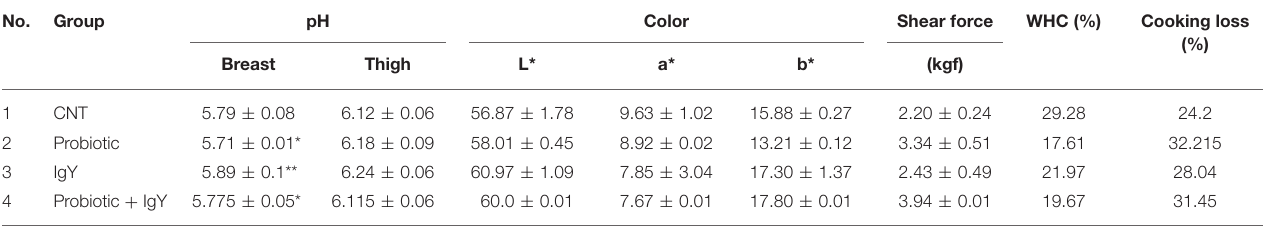
TABLE 4 | pH values of breast and thigh, color, shear force (kgf), water holding capacity percentage, and cooking loss percentage of broilers groups supplemented by variant feed additives. No.